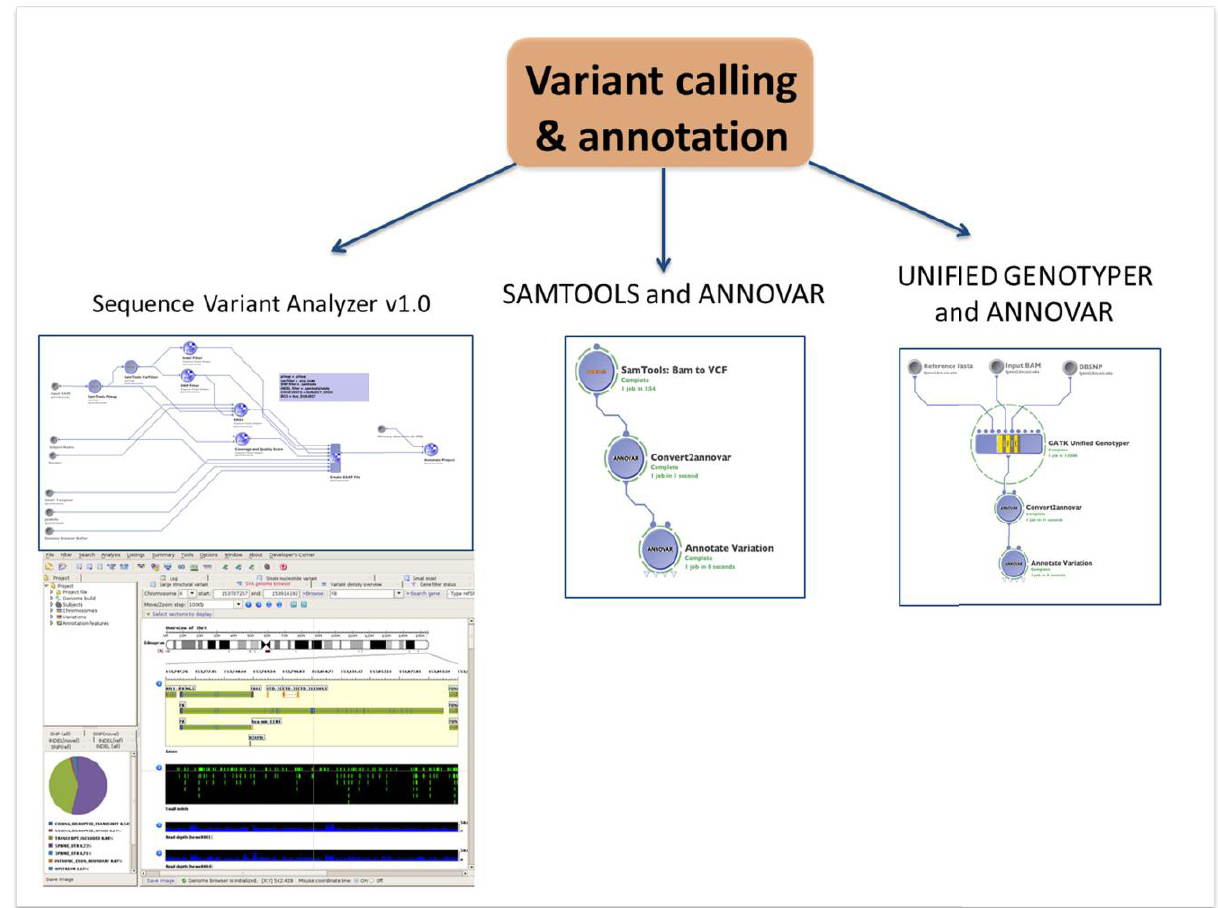
Figure 7. A snapshot of the three independent workflow for variant calling, and annotation workflows available. Sequence Variant Analyzer (SVA) displays a graphical user interface (GUI) to visualize, annotate, filter and analyze the called